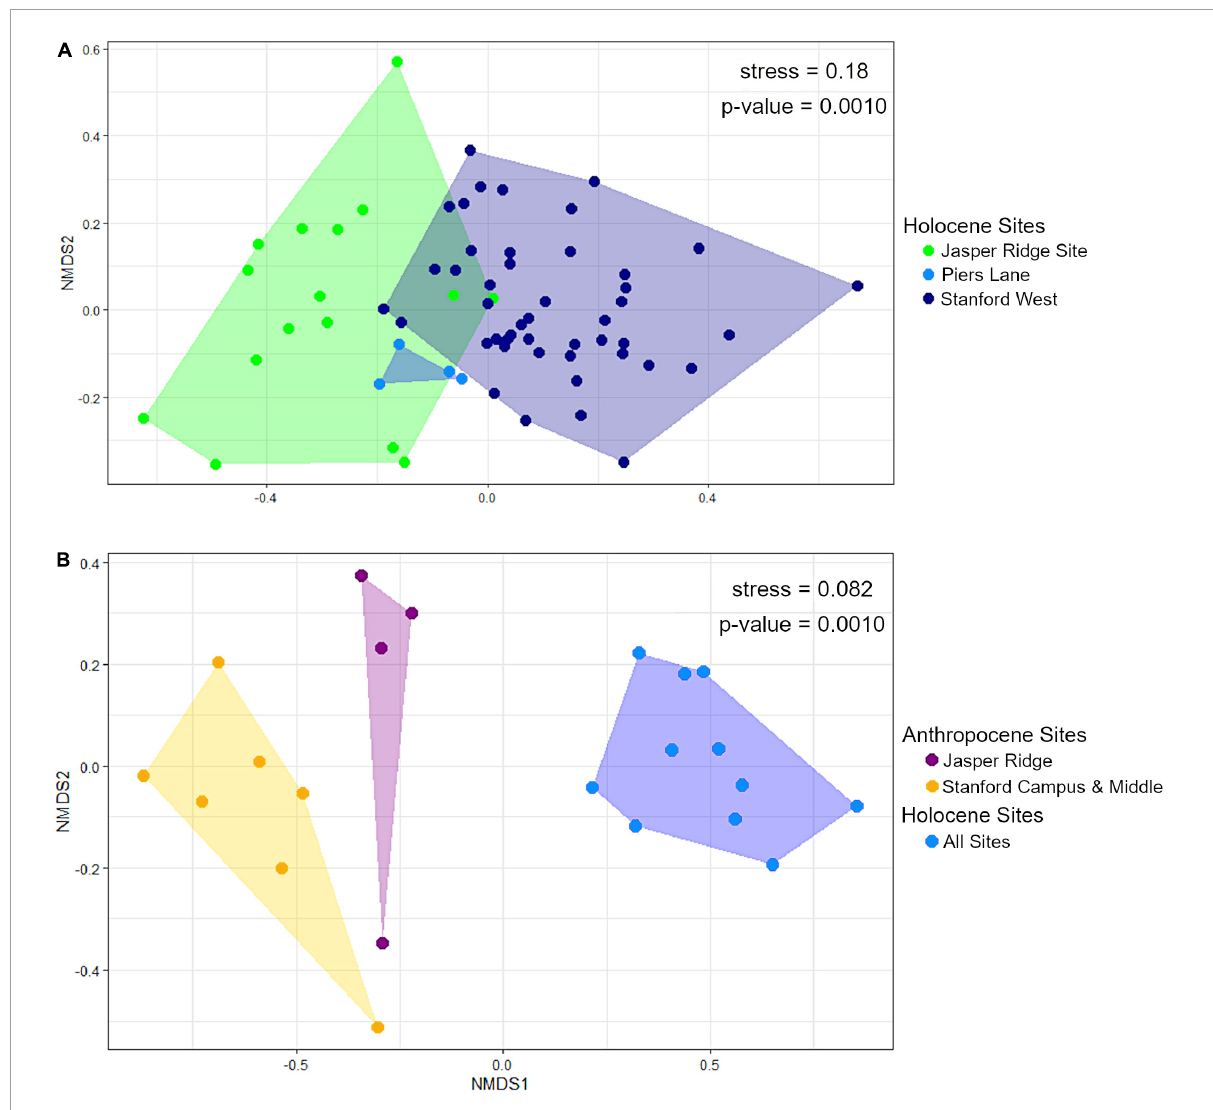
FIGURE5 NMDS plots of (A) Holocene sites by unit, and (B) Anthropocene (binned by collection year) and Holocene (binned in 30-cm levels) sites. For panel (B) . Anthropocene Stanford campus and Anthropocene Middle as well as all Holocene sites are grouped together because they are not significantly different from each